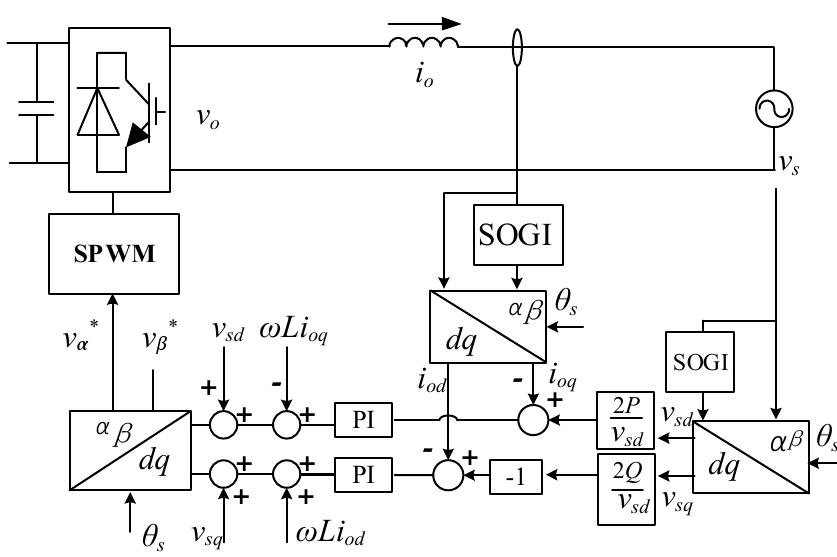
Figure 5. Block diagram of PQ control strategy with power as outer loop.